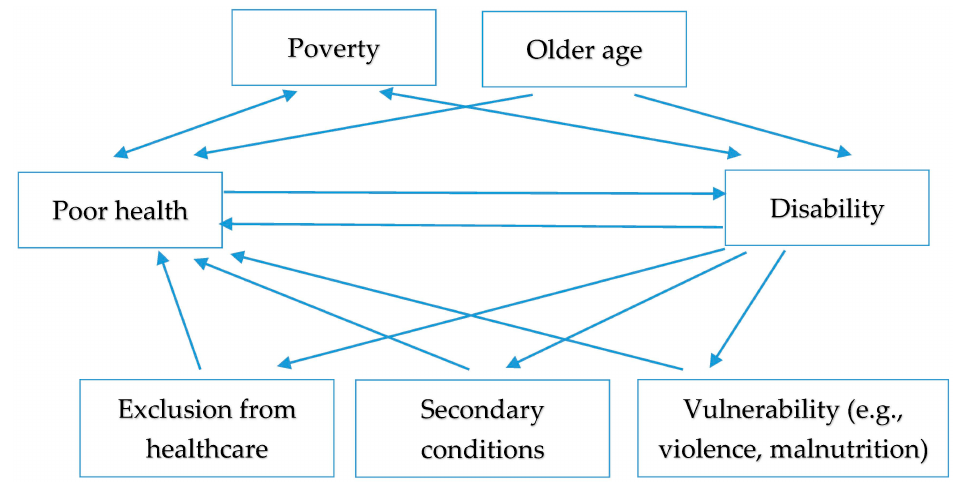
Figure 1. Complex relationship between disability and poor health.